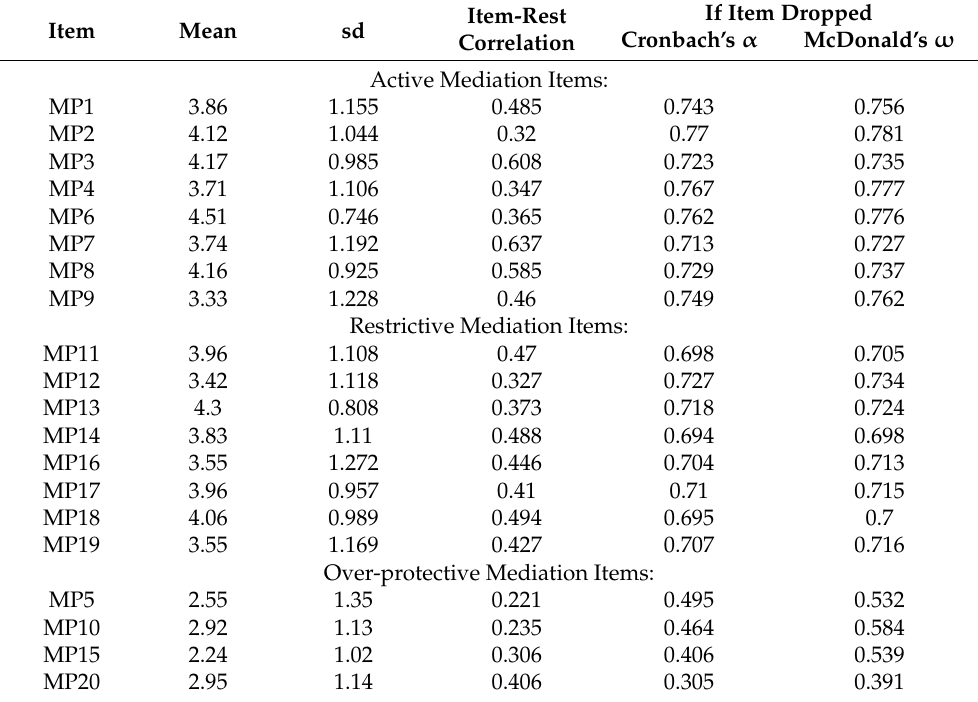
Table 3. MEPA-20 Items Reliability Statistics.